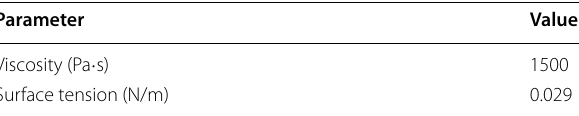
Table 2 Performance parameters of the thermoplastic resin Parameter Value